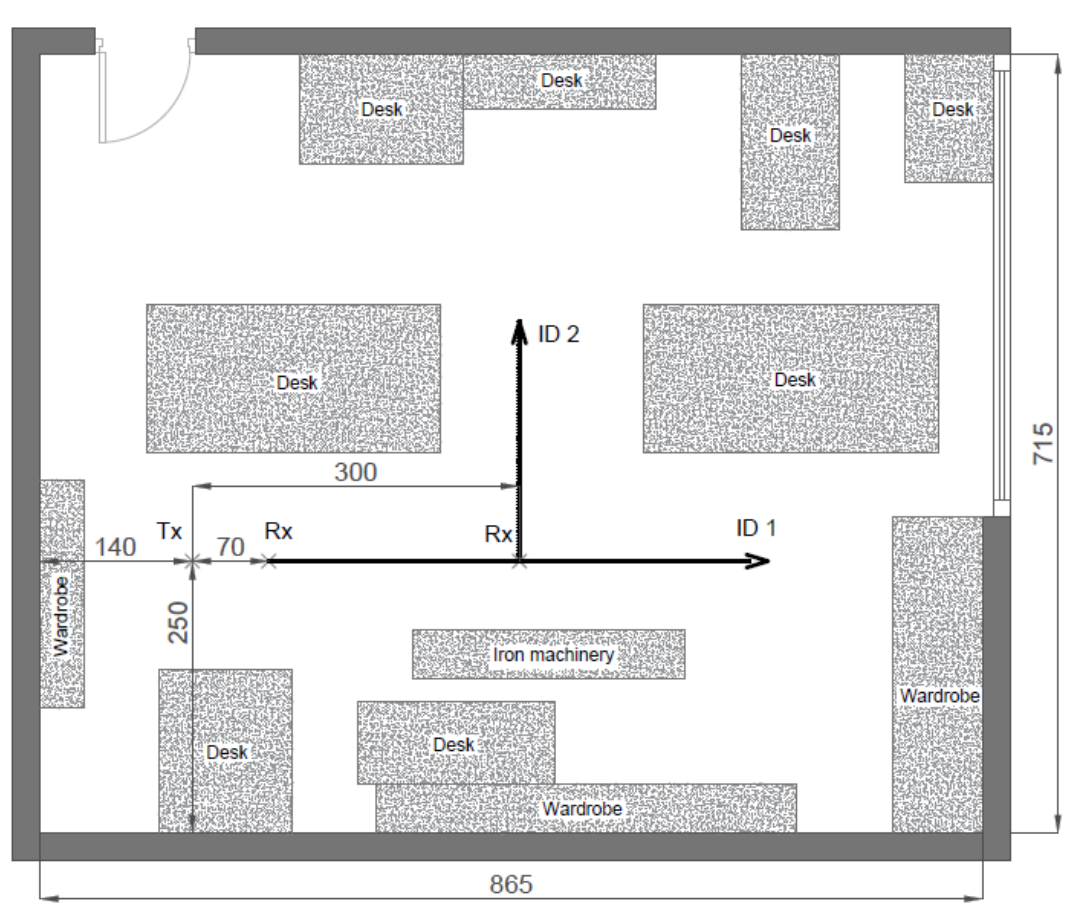
Figure 4. Floorplan of the laboratory with dimensions in cm.